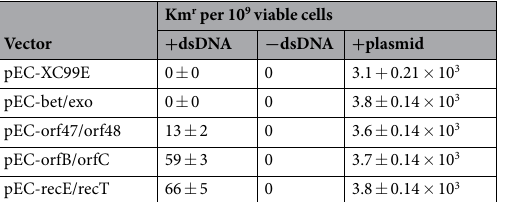
Table 1. Comparison of the recombination efficiencies of different orthologous exonuclease-recombinase pairs for linear dsDNA. 0.5 μ g CrtB/400-Kan cassette or plasmid was used for recombination assay, with a kanamycin concentration of 25 mg L − 1 . All assays were repeated three or more times. Km r , kanamycin